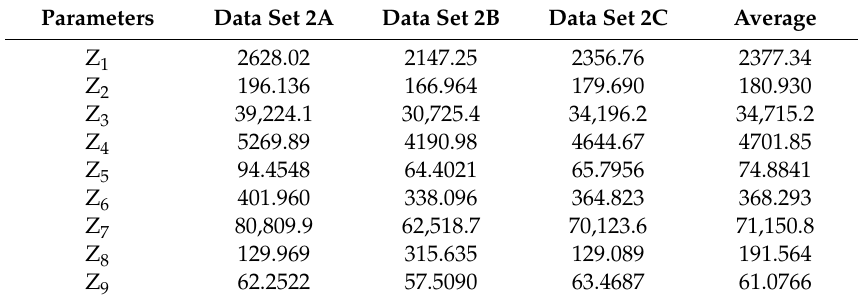
Table 3. Averages of the µ * values across the nine SA runs of each data set in Category 2, the data from experiments using 0.5 wt% Pt, 25 wt% Co / Al 2 O 3